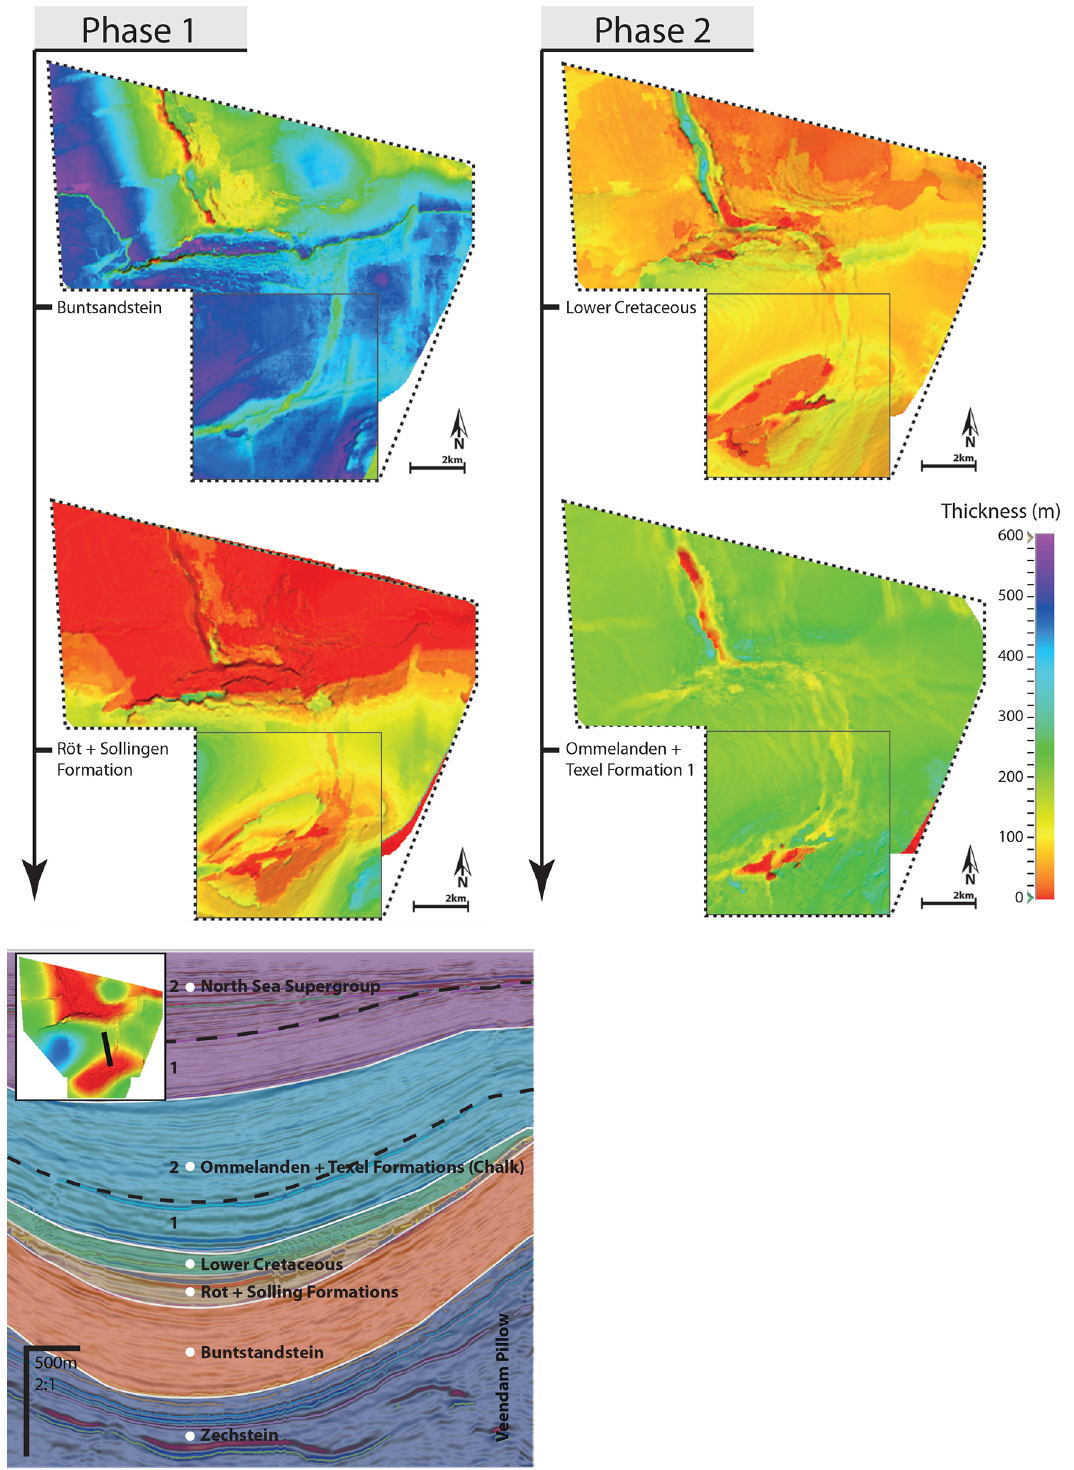
www.solid-earth.net/7/67/2016/ Solid Earth, 7, 67–82,